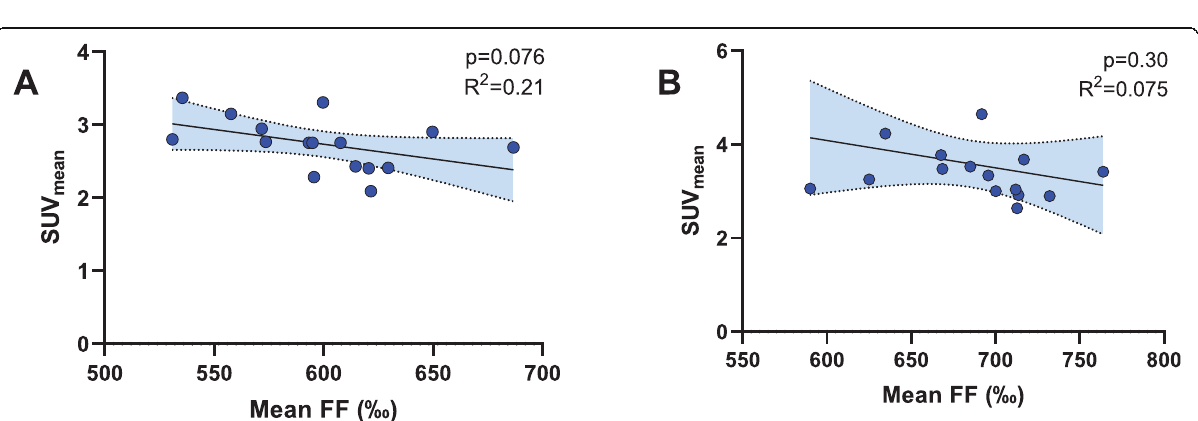
Fig. 5 Simple linear regression plots with SUV mean (g/ml) as dependent variable versus tissue fat fraction ( ‰ ) as the independent